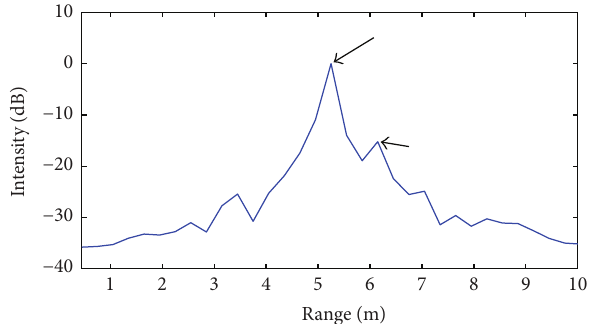
Figure 13: Radar intensity profile obtained from standard radar processing (IFT): experimental scenario of Figure 12.